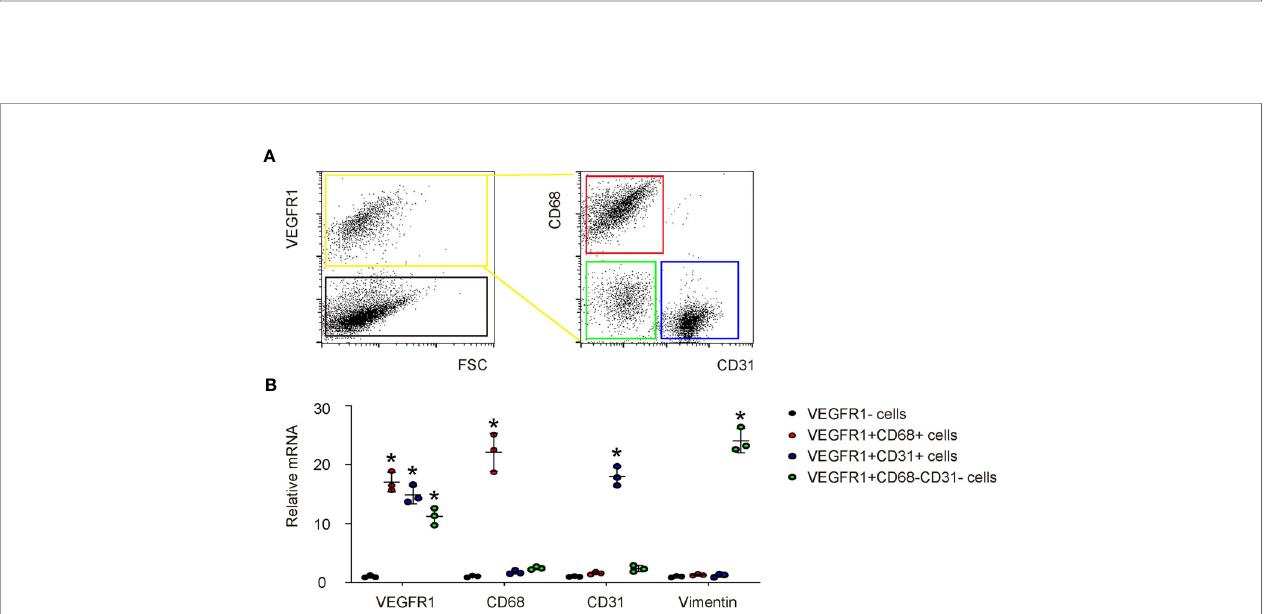
FIGURE 2 | VEGFR1 is expressed in macrophages, endothelial cells and fi broblasts in DFD tissue. (A) A representative fl ow chart to show digestion of day 3 DFD tissue into single cell population and a subsequent sorting of VEGFR1+ cells versus VEGFR1- cells by fl ow cytometry. Afterwards, the VEGFR1+ cells were sorted for CD68 and CD31 to further separate VEGFR1+ cells into VEGFR1+CD68+ cells (macrophages), VEGFR1+CD31+ cells (endothelial cells), and VEGFR1+CD68-CD31- cells (VEGFR1+ cells that are not macrophages or endothelial cells). (B) RT-qPCR for VEGFR1, CD68, CD31 and vimentin on the sorted 4 cell fractions. *p <